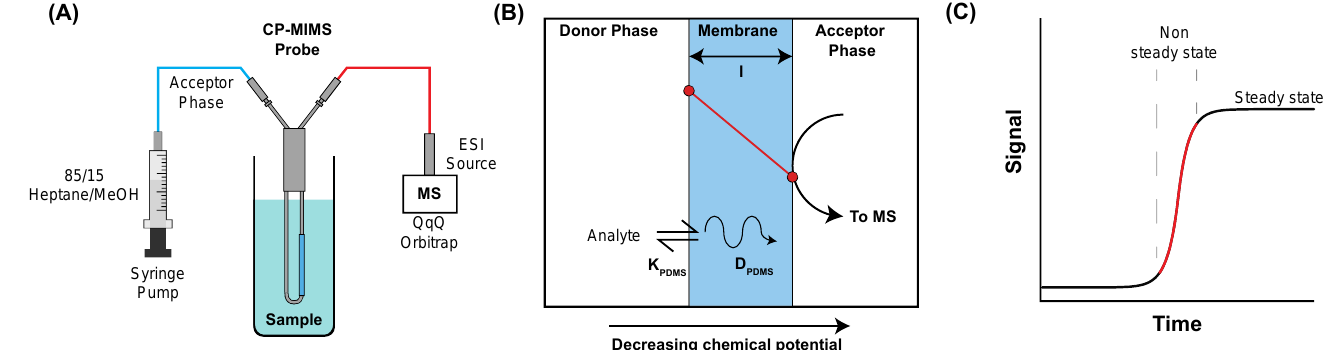
Figure 1. Schematic overview of CP-MIMS operation and theory; ( A ) online monitoring with a hollow capillary membrane immersion probe with a flowing solvent (acceptor phase) directly infused into MS, ( B ) cross-section of sample (donor)/membrane/solvent (acceptor) depicting the analyte partitioning into (K pdms ) and diffusing across (D pdms ) the membrane under a concentration gradient, ( C ) time-resolved MS signal as analyte permeation reaches steady state. Table 1. Summary of information for the OSPW extracts employed for evaluation of CP-MIMS membrane